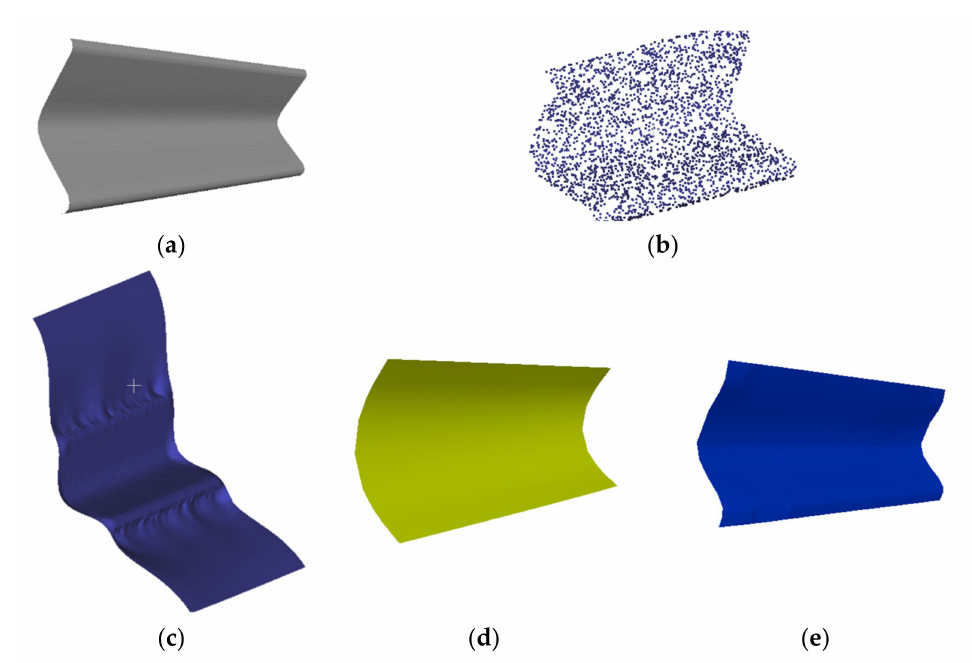
Figure 9. ( a ) The ground truth of a bench surface; ( b ) point set of a bench surface; ( c ) surface reconstructed using Poisson; ( d ) PDE-based surface using a single 16-variables PDE model; and ( e ) PDE-based surface using a single 64-variables PDE